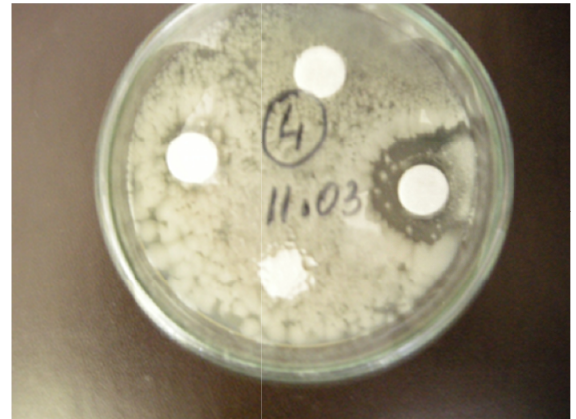
Fig. 4. Diameters of the inhibiting zones